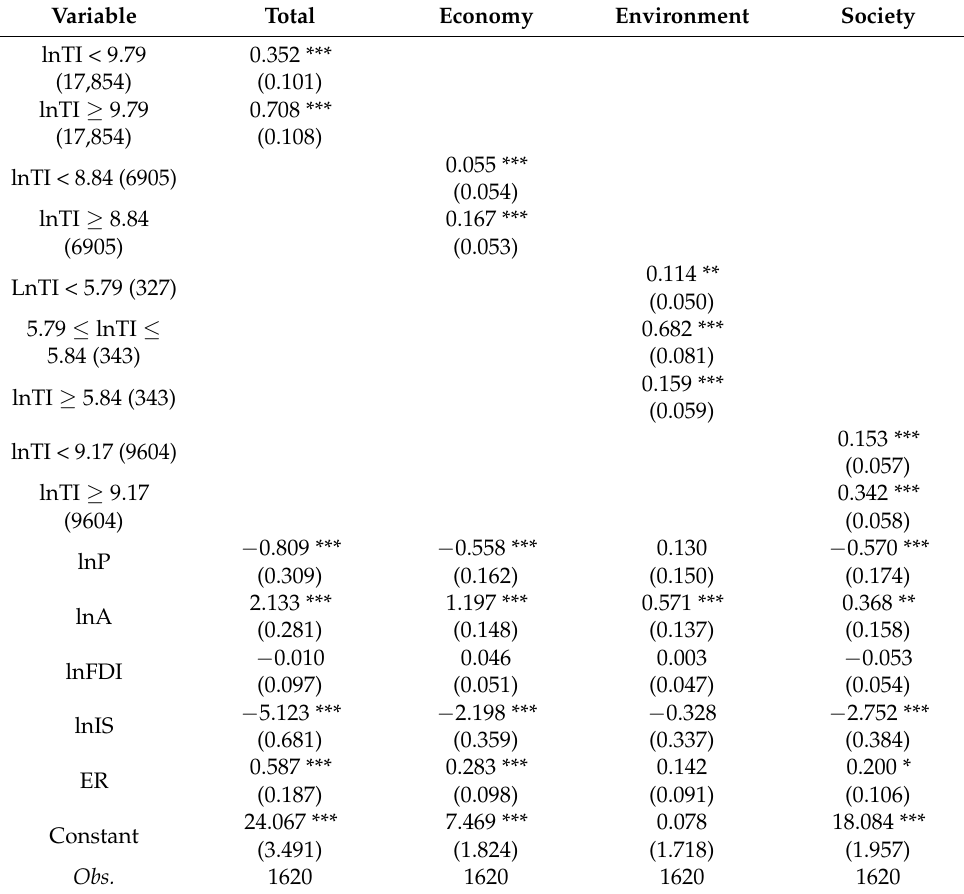
Table 7. Threshold analysis of TI on green development in the YREB.